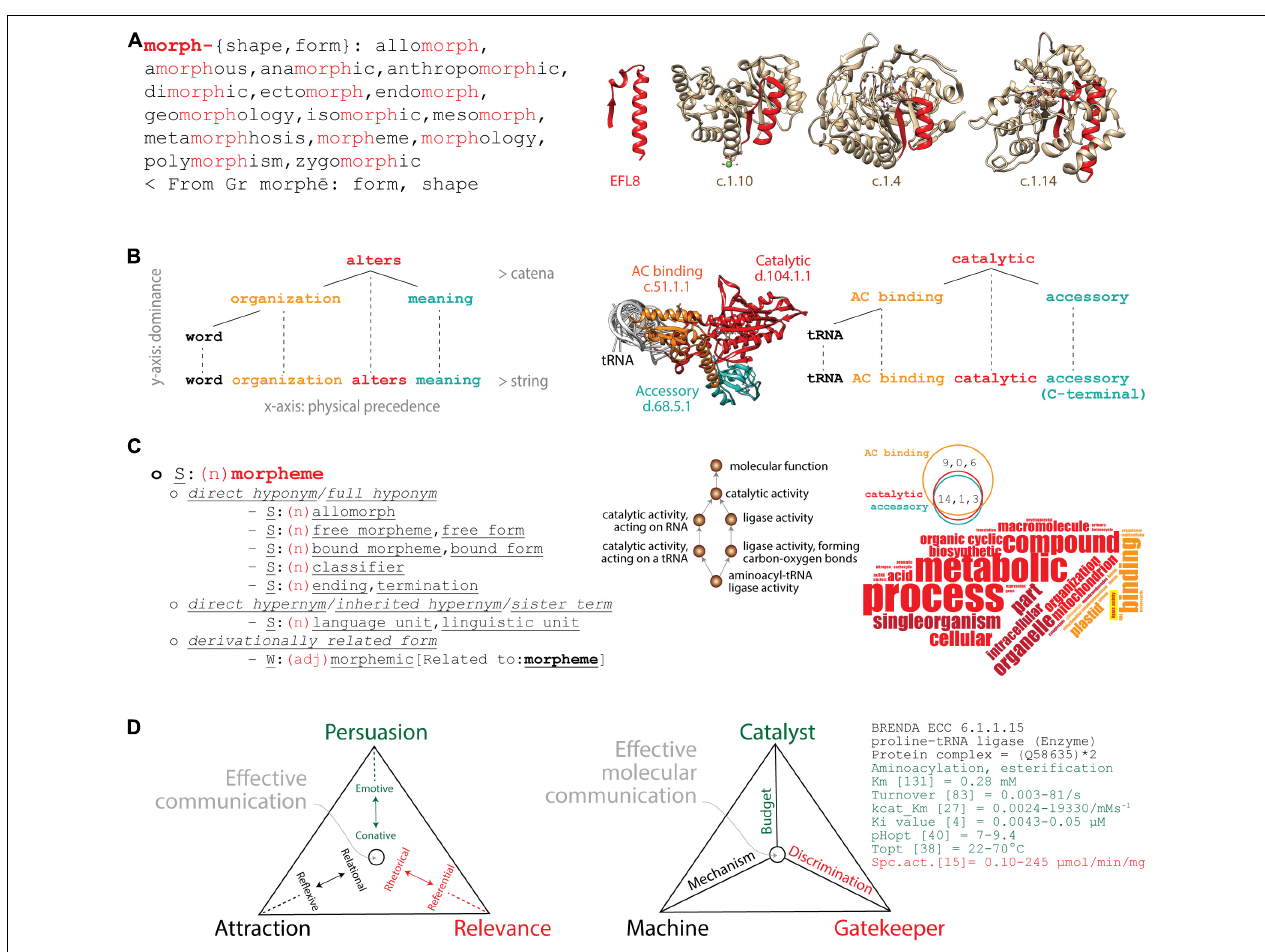
FIGURE 1 | Analogies between linguistics and molecular biology. (A) Lexicon–Module correspondence: Morphemes combine to form words (left) as “elementary functional loops” (EFLs) combine to form structural domains in proteins (right). The morpheme “morph” is a lexical unit (highlighted in red) of cognate words with common origin. The list of cognates retrieved from the Cogn¯atarium (http://www.cognatarium.com/cognatarium/) includes the word “morpheme.” EFL8 (highlighted in red) is a structural unit of β / α -barrel domains with common evolutionary origin, including the catalytic domain of RubisCo (c.1.14), Earth’s major carbon-fixing enzyme (Caetano-Anollés, 2017). (B) Syntax–Structure correspondence: Words combine to form language expressions (left) as protein structural domains combine to form protein structures (right). The dependency grammar of a clause can be described with an ordered tree and catenae reflecting actual word order. The syntactic hypothesis is constructed top-to-bottom to provide a meaning to the message. Similarly, a dependency molecular grammar can also be constructed for the prolyl-tRNA synthetase (ProRS) multidomain enzyme (PDB entry 1 h 4 s) with its catalytic, anticodon (AC) binding and accessory structural domains. The age of domains is traced on an atomic model of the enzyme, red being ancient and turquoise recent. The tRNA is viewed coaxially from its anticodon (AC)-binding arm and serves as a point of reference. (C) Semantics–Function correspondence: Hyponyms and hypernyms describe semantic relationships as Gene Ontology (GO)-based lexical and conceptual semantic statements describe biological functions. The semantic field of “morpheme” (noun) can be described with sets of cognitive synonyms (synsets) expressing individual concepts and visualized interlinked by means of conceptual-semantic and lexical relations using the WordNet R (cid:13) lexical database (https://wordnet.princeton.edu). Similarly, GO terms associated with the “aminoacyl-tRNA ligase activity” of the ProRS structural domains form a network of functional associations. A word cloud of GO terms extracted from the Superfamily database (https://supfam.mrc-lmb.cam.ac.uk/SUPERFAMILY/) describes domain-associated biological processes ( bp ), molecular functions ( mf ), and cellular compartments ( cc ) (depicted as vertical, horizontal, and oblique words, respectively); the Venn diagram shows how bp , mf , and cc terms (in that order) are shared by domains. Red terms describe properties of the catalytic domain (which are common to all domains), and orange terms describe properties unique to the AC-binding domain. Highlighted in yellow is “ligase activity,” the only mf term describing the catalytic core and the main enzymatic activity of the enzyme. Darker shades are terms that do not apply directly to the respective domains. Note how the accessory domain does not have unique terms, since there are no words colored turquoise. (D) Pragmatics–Fitness correspondence: A triangle of effective communication describes how context contributes to meaning as a triangle of effective molecular communication describes the fitness parameters of a molecular system. Triangles showcase trade-off solutions of Persuasion, Relevance, and Attraction imposed by linguistic factors and functions (in parentheses): sender (emotive) and receiver (conative), context (referential) and message (rhetorical), contact (relational) and code (reflexive). Pairs of these functions push effective communication toward individual vertices of the triangle to maximize fitness. The triangle describing effective molecular communication of the ProRS enzyme (EC 6.1.1.15) pushes matter–energy budget toward the Catalyst vertex (Persuasion), discrimination toward the Gatekeeper vertex (Relevance), and mechanism toward the Machine vertex (Attraction). The Brenda repository of enzyme information (https://www.brenda-enzymes.org) provides parameters (see list as examples) that can inform about trade-offs.